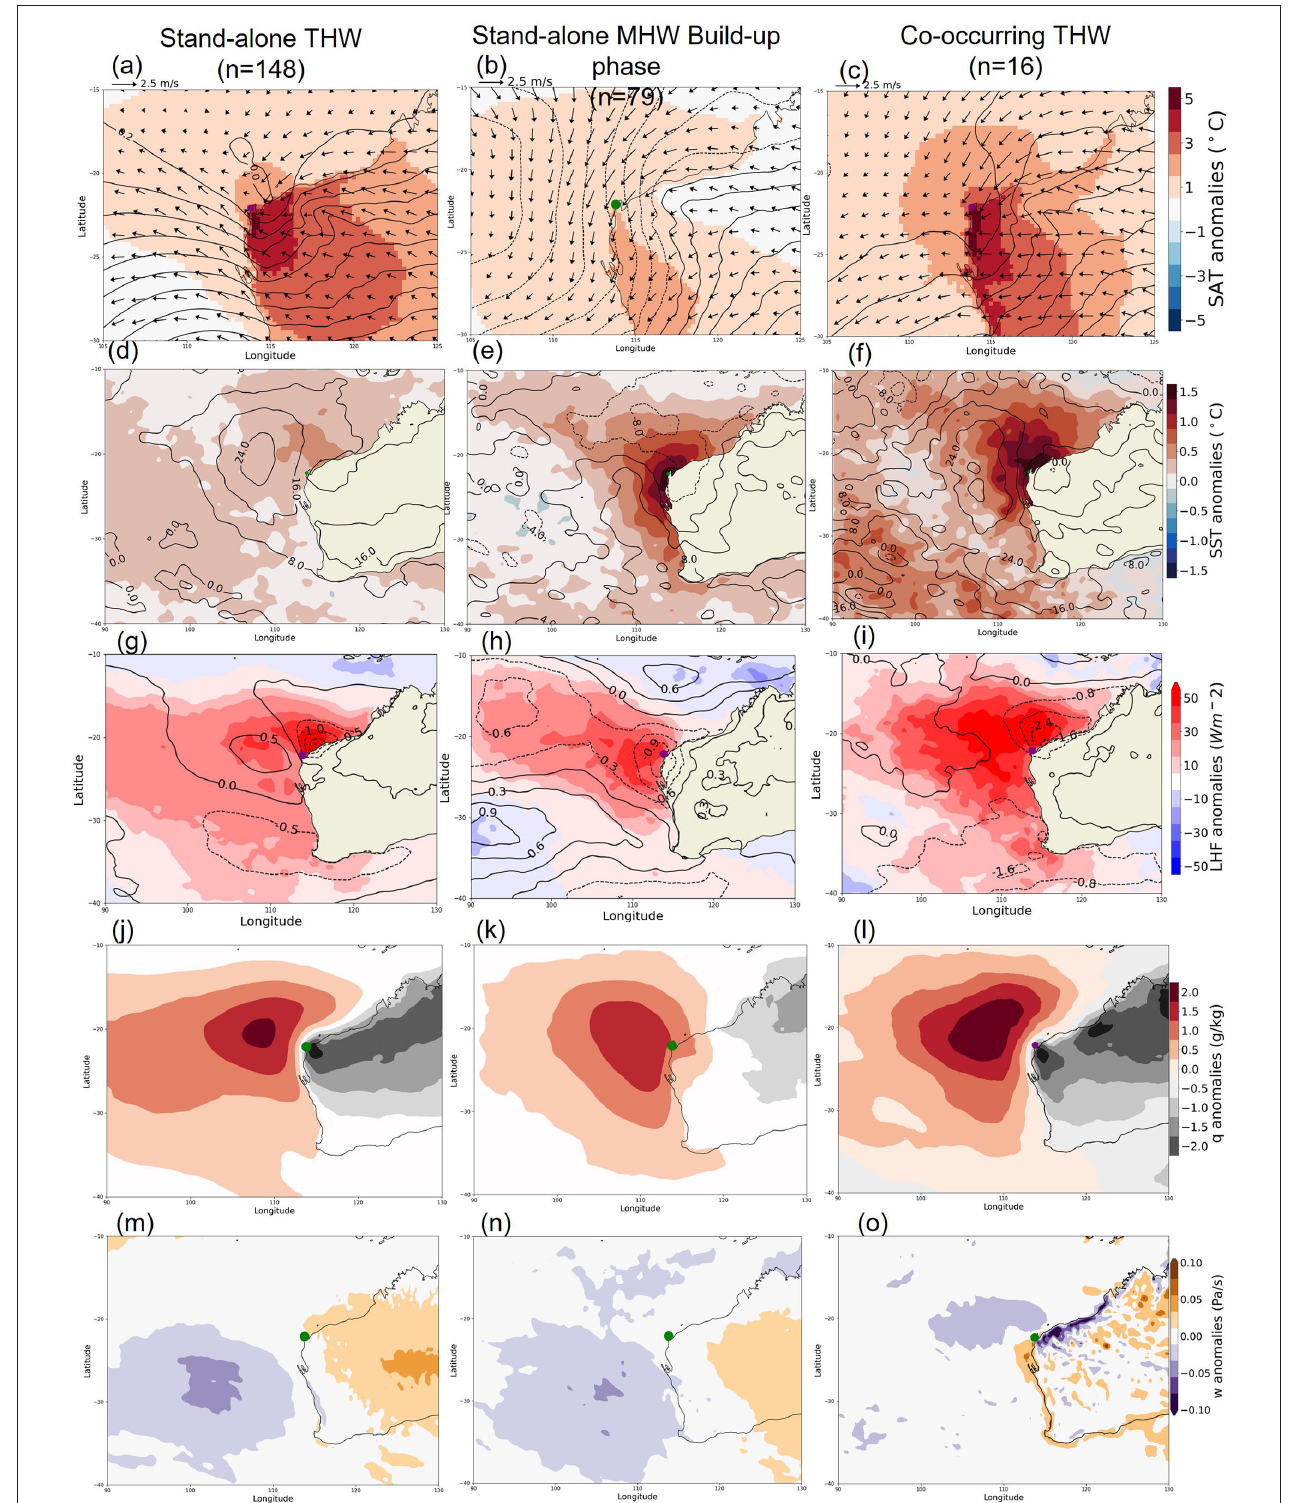
FIGURE 9 | Composite synoptic conditions for stand-alone THWs (left column), stand-alone MHW build-up (center) and co-occurring THW (right column) in Ningaloo. (a–c) show SAT anomalies (shaded), MSLP anomalies (line contours) and wind vectors. (d–f) show SST anomalies (shaded) and SWR anomalies (line contours). (g–i) show LHF anomalies (shaded) and windspeed anomalies (line contours). (j–l) show specific humidity anomalies. (m–o) show vertical velocity anomalies at 850 hPa. Negative LHF implies a flux of heat from the land/ocean surface to the atmosphere.